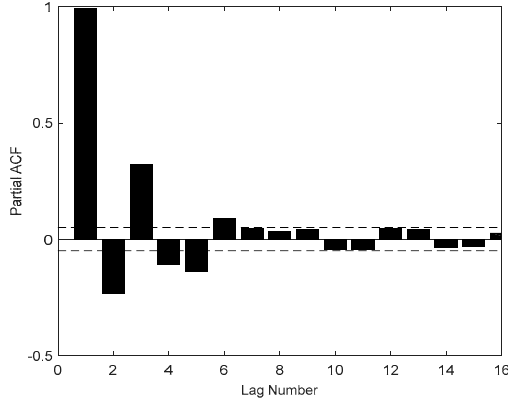
Figure 14. The PCAF results of Hubei carbon price after WT.